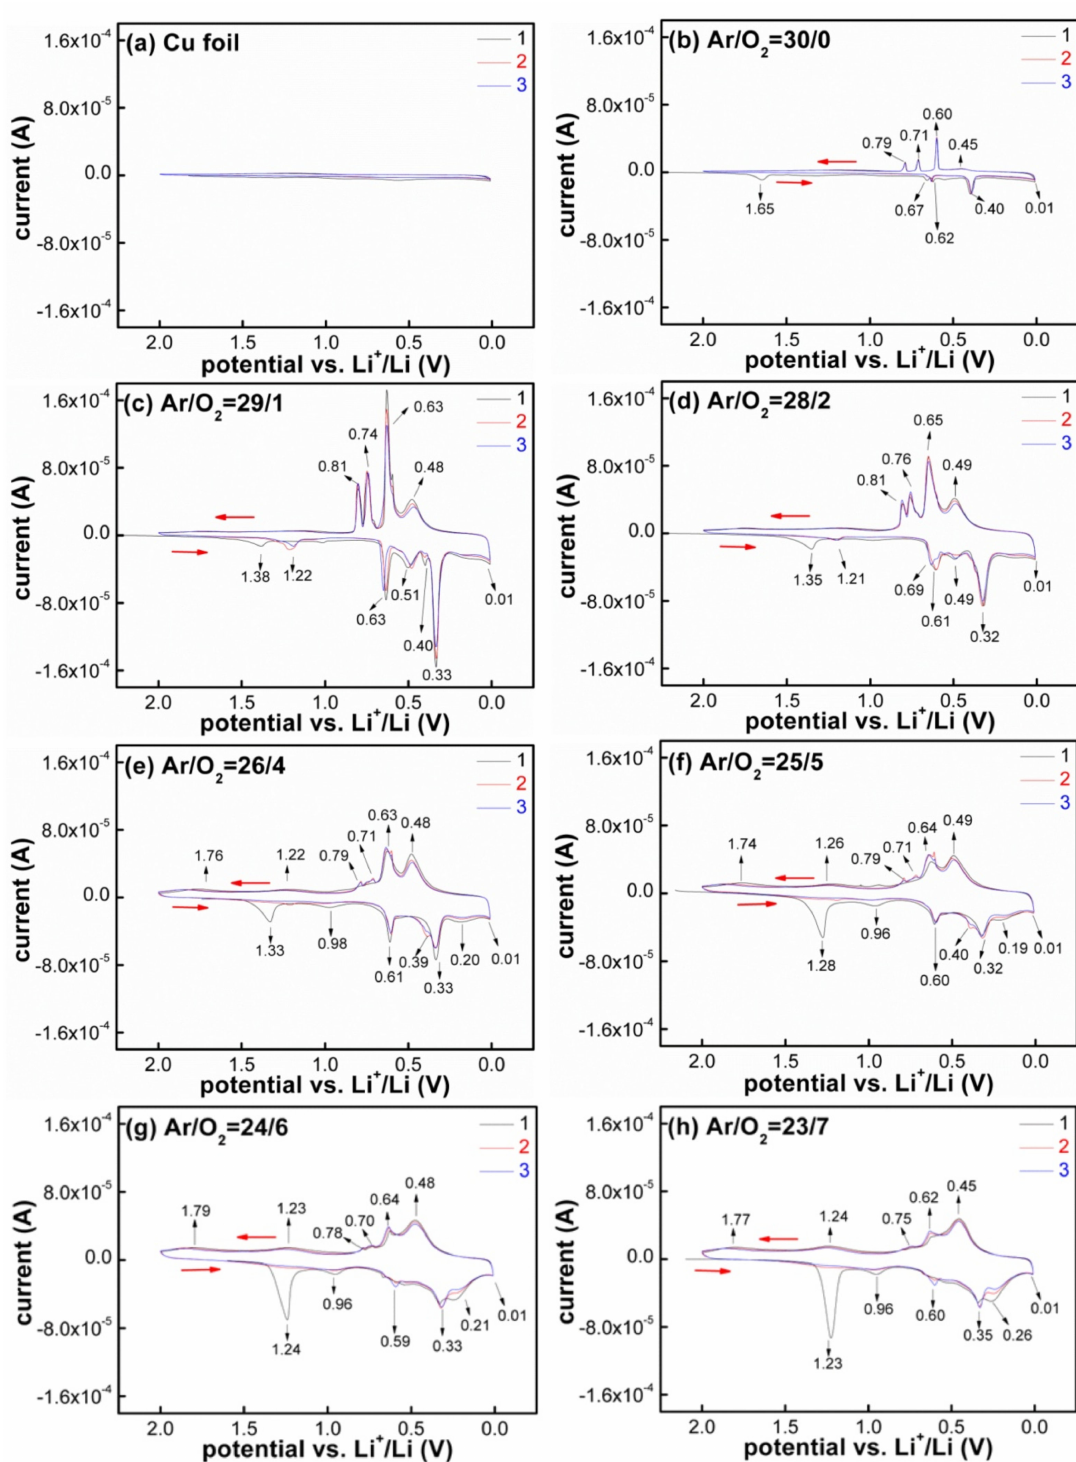
Figure 5. CV curves of the SnO x films deposited with different Ar/O 2 flow ratios: ( a ) bare Cu foil, ( b ) 30/0, ( c ) 29/1, ( d ) 28/2, ( e ) 26/4, ( f ) 25/5, ( g ) 24/6 and ( h )